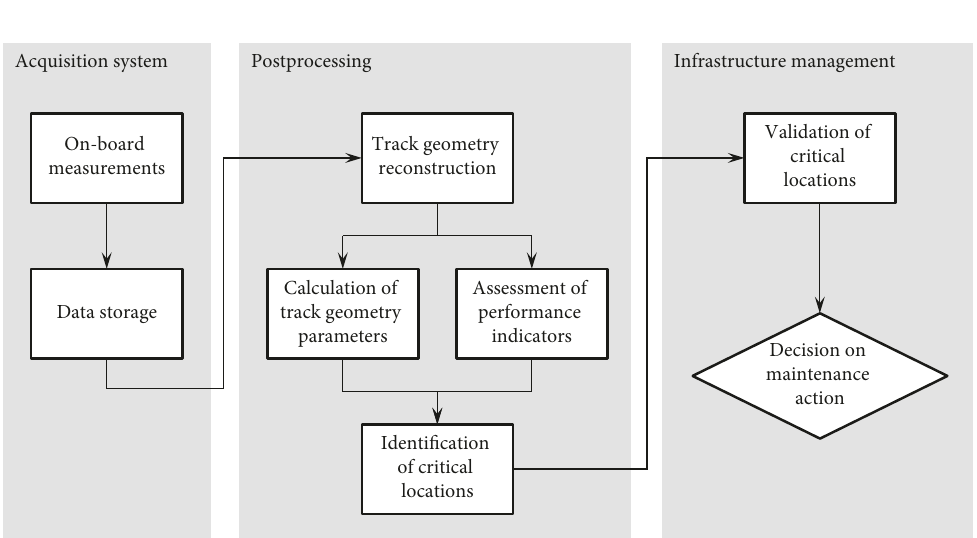
Figure 12: Schematic representation of the proposed method for complementary monitoring of railway